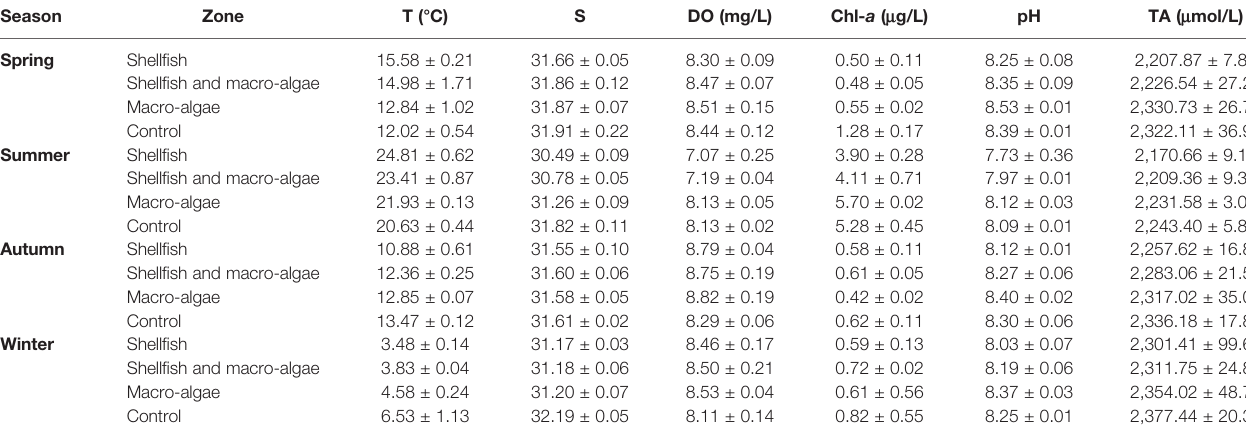
TABLE 1 | Seasonal variation of average value of different environmental parameters in Sanggou Bay.